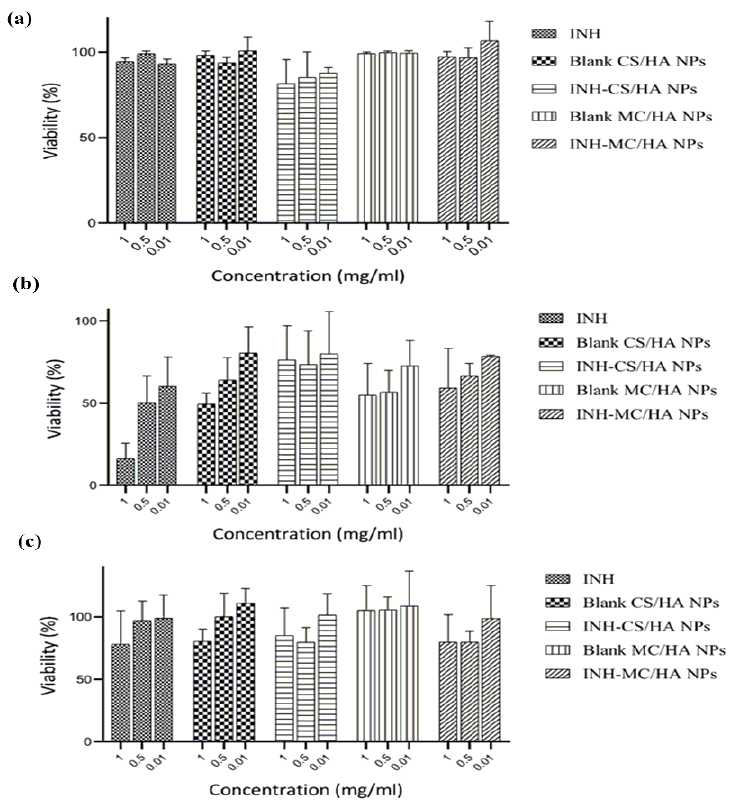
Figure 6. Effect of nanoformulations on the viability of A549 cells ( a ), Raw 264.7 macrophages ( b ), and primary culture of macrophages derived from human blood ( c ). The results were obtained after incubation of different concentrations of the nanoparticles (0.01, 0.5, 1 mg/mL) over 24 h. All the results were performed in triplicate and are expressed as mean ± S.D.